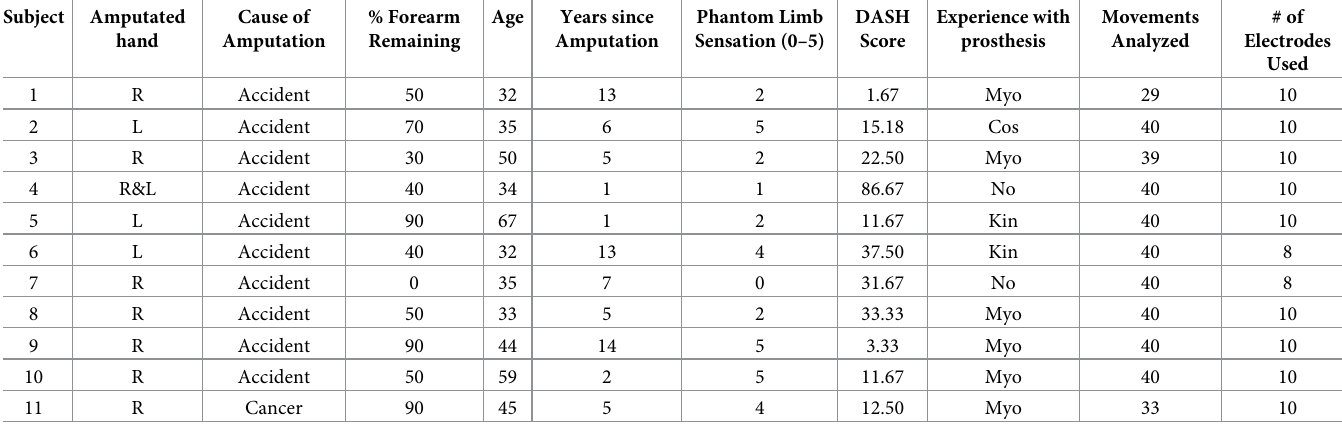
Table 1. Summary of clinical characteristics of database 3.